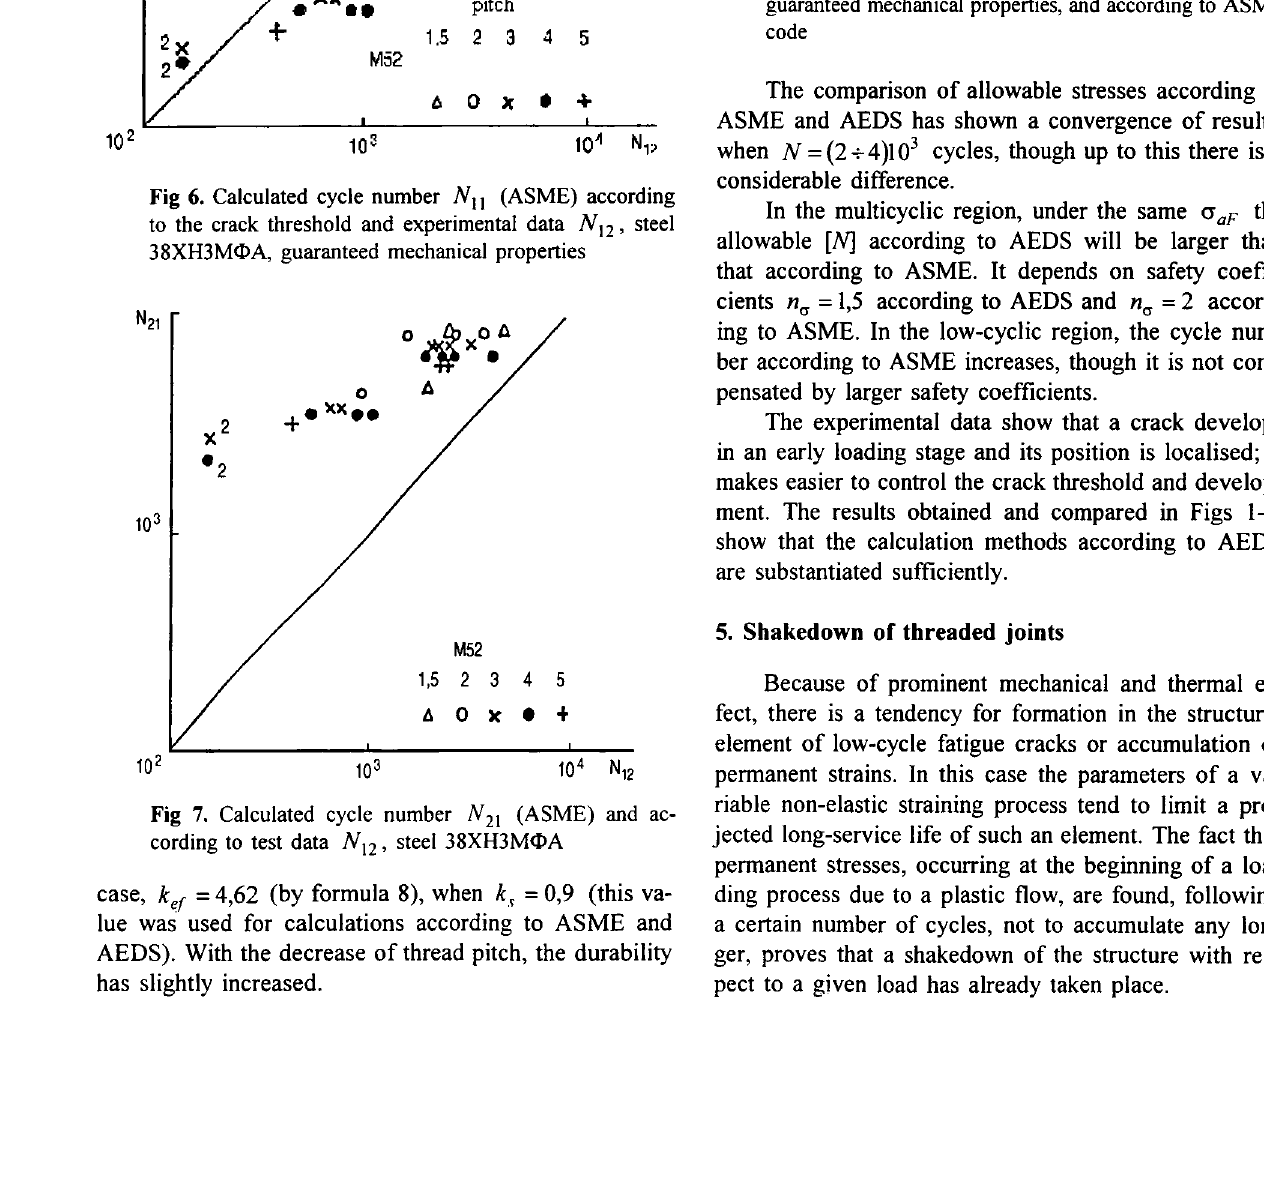
Fig 8. Allowable cycle number [N] according to AEDS, guaranteed mechanical properties, and according to ASME